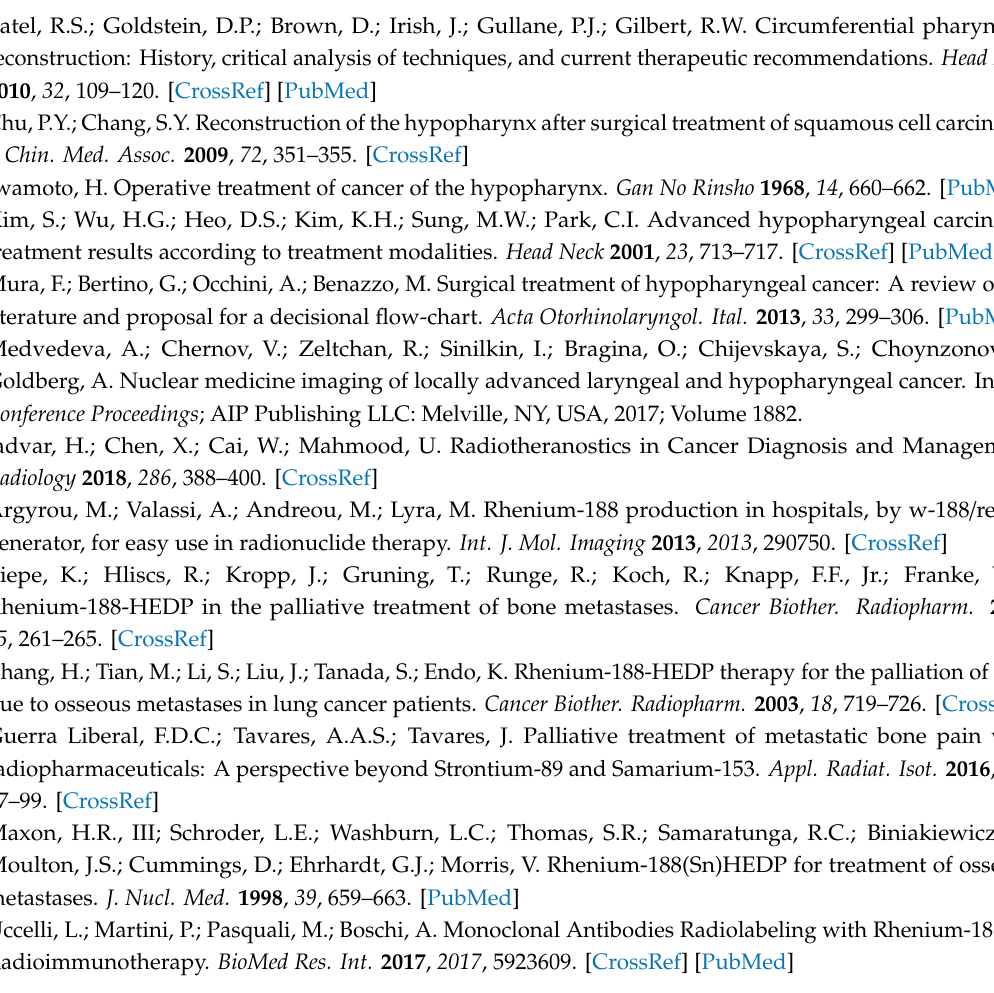
Supplementary Materials: The following are available online, Figure S1: Measurement of the combined e ffi ciency between 188 Re and BMEDA chelator for embedding into liposome. Figure S2: Demonstration of reporter genes expression in FaDu-3R cells. Figure S3: Qualification of total RNA for NGS analysis. Figure S4: GC content analysis and sequencing qualification of RNA–Seq. Figure S5: A heatmap of di ff erentially expressed microRNAs with or without 188 Re-liposomal treatment. Figure S6: A heatmap of selected di ff erentially expressed microRNAs in normal tissues and larynx cancer tissues using the clinical information of